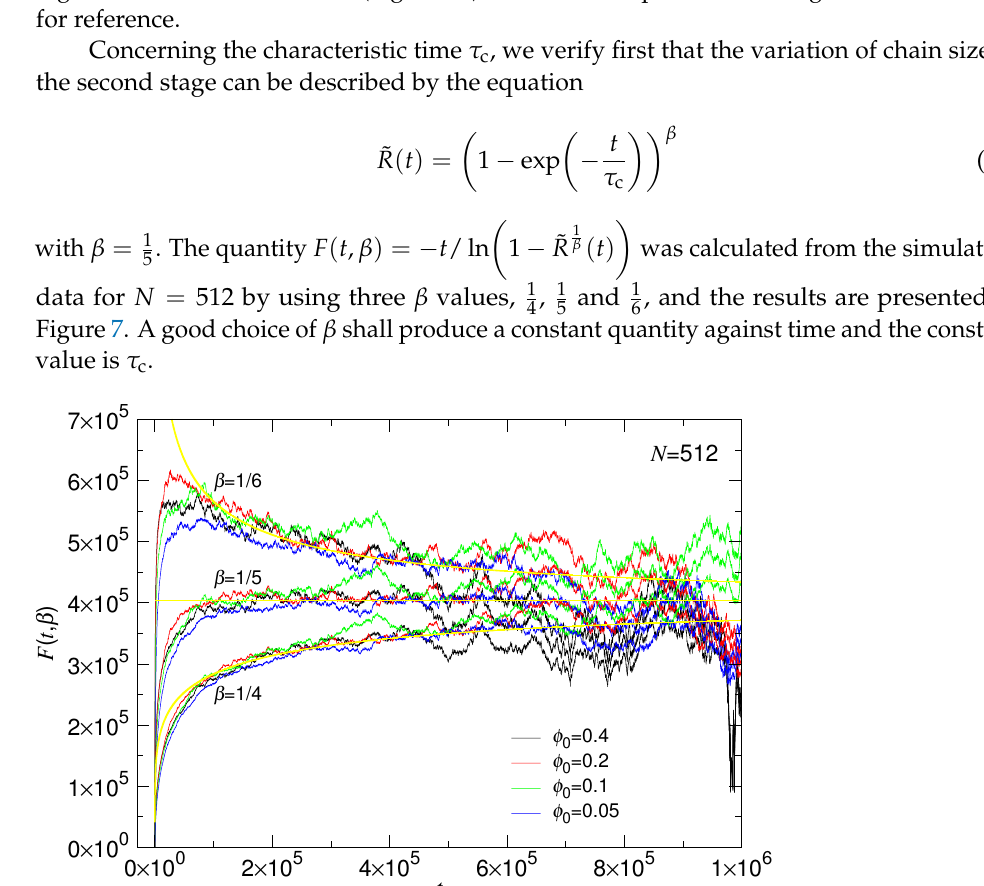
(cid:17) (cid:16) 1 1 − ˜ R calculated from the simulation data for N = 512, β ( t ) , 1 and 1 . The value of φ 0 is given in the legend. The theoretical curves for 5 6 4 (cid:16) (cid:16) (cid:17)(cid:17) 1/5 − t 1 − exp 4.03 × 10 5